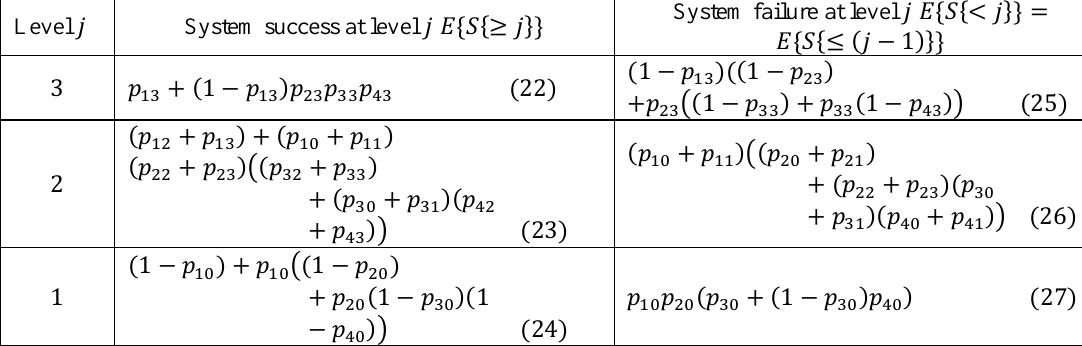
Table 3. Expectations of system success and failure at each non-zero level 𝑗 (𝑗 = 1, 2. 3) . Level